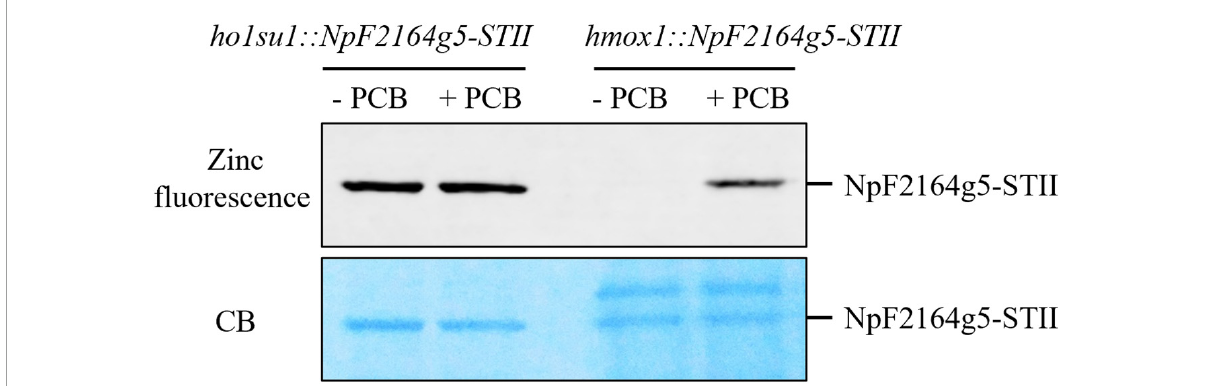
FIGURE4 Bilin biosynthesis in ho1su1 . Cyanobacterial NpF2164g5, a PCB binding reporter, was expressed in the chloroplasts of hmox1 and ho1su1 . Affinity purified NpF2164g5-STII protein was assembled with (+ PCB) or without PCB (– PCB) in vitro and detected using a